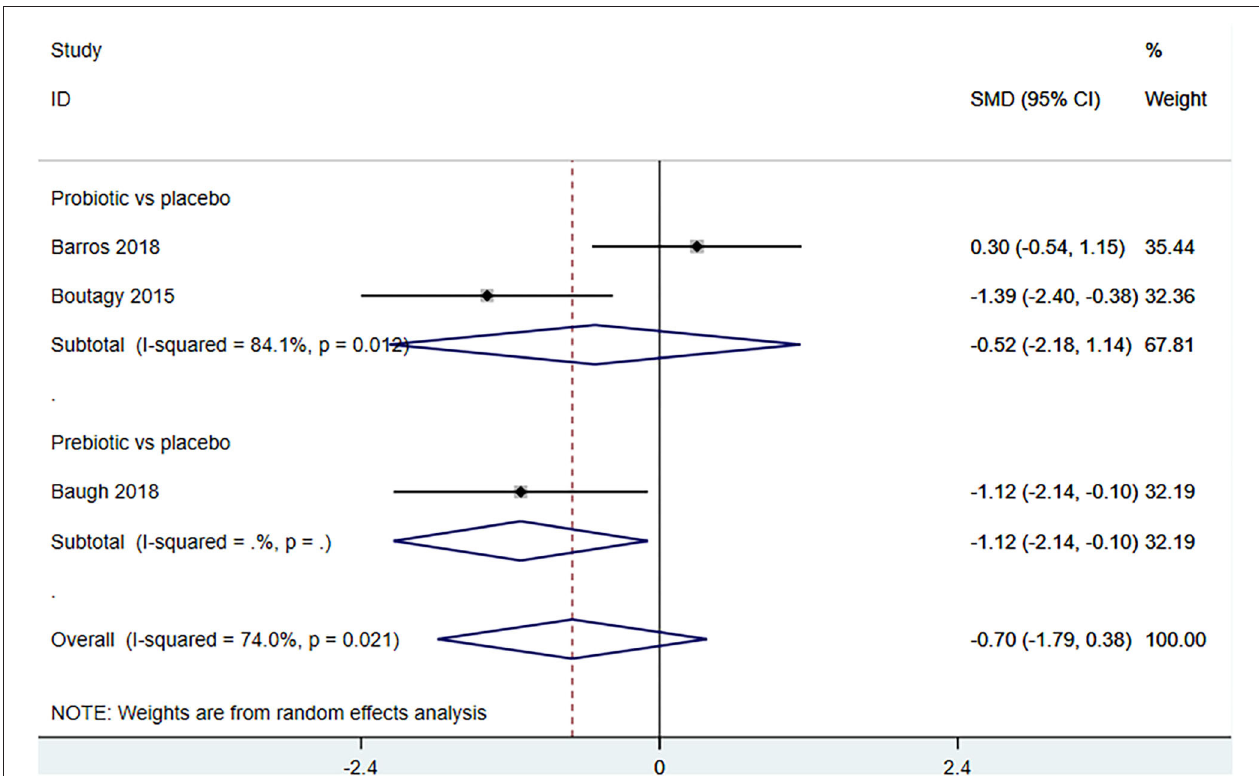
FIGURE 10 | Forest plot for the effect of microbiota-driven therapy on circulating betaine aldehyde level (subgroup analysis). The effect size of each trial or the overall was represented as black diamond and the weight of each trail in the overall study was represented as gray box around black diamond. The estimated 95% confidence interval of effect size was identified by extending lines. CI, confidence interval; RCT, randomized controlled trial; SMD, Standard Mean